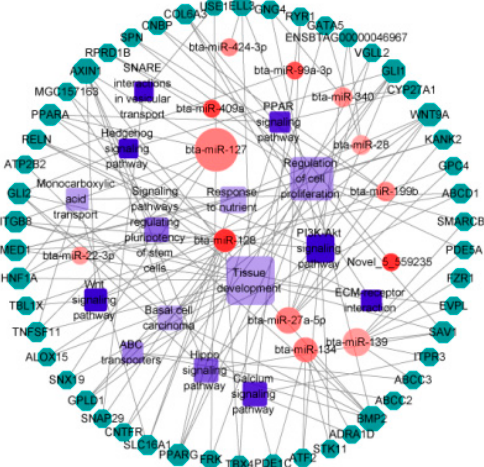
Figure 6. Analysis of miRNA-mRNA-cluster network among DEmiRNAs, target genes, and clusters of interest. Circles represent DEmiRNAs, octagons represent genes, and squares represent clusters. The size of the shape indicates the number of targets. The deeper the color of the red circle, the greater the absolute value of log 2 FC, and the deeper the color of the blue square, the greater the p value.